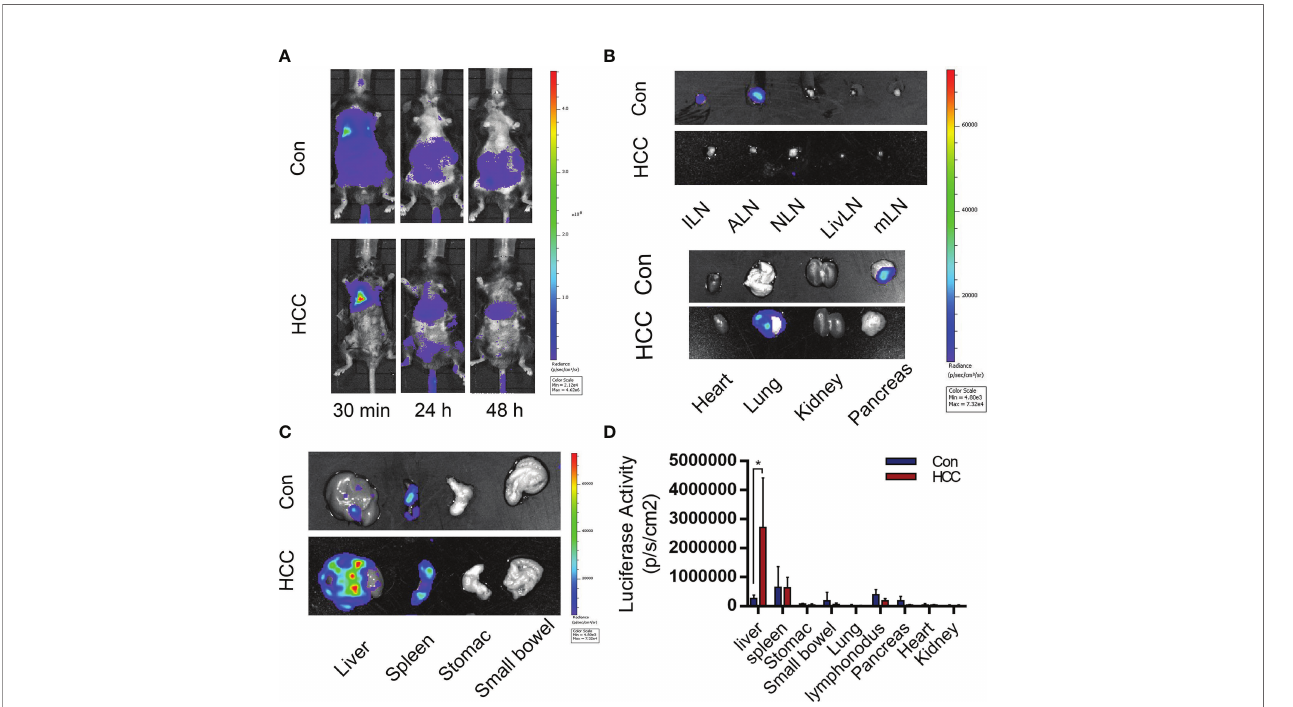
FIGURE 5 | Distribution of bone marrow-derived macrophages (BMDMs) in the control and tumor-bearing mouse model. (A) BMDMs ’ migration from 30 min to 48 h after cell injection. (B, C) BMDMs are mainly distributed in the tumor-bearing mice liver and spleen. (D) Statistical analysis of the luciferase activity in major organs. Mean ± S.D; n=3, Statistical signi fi cance is determined with t test; *P<0.05.